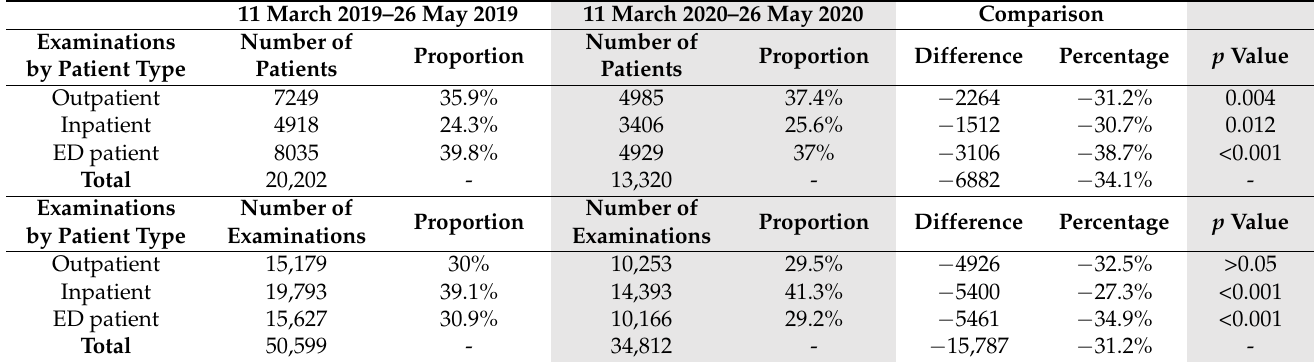
Table 4. Number of patients and diagnostic investigations performed within the ordinary activity the radiology department of our hospital; data are sorted relative to patient type, and the proportions for each category are reported. The comparisons between the two periods are expressed in absolute numbers and percentage changes.